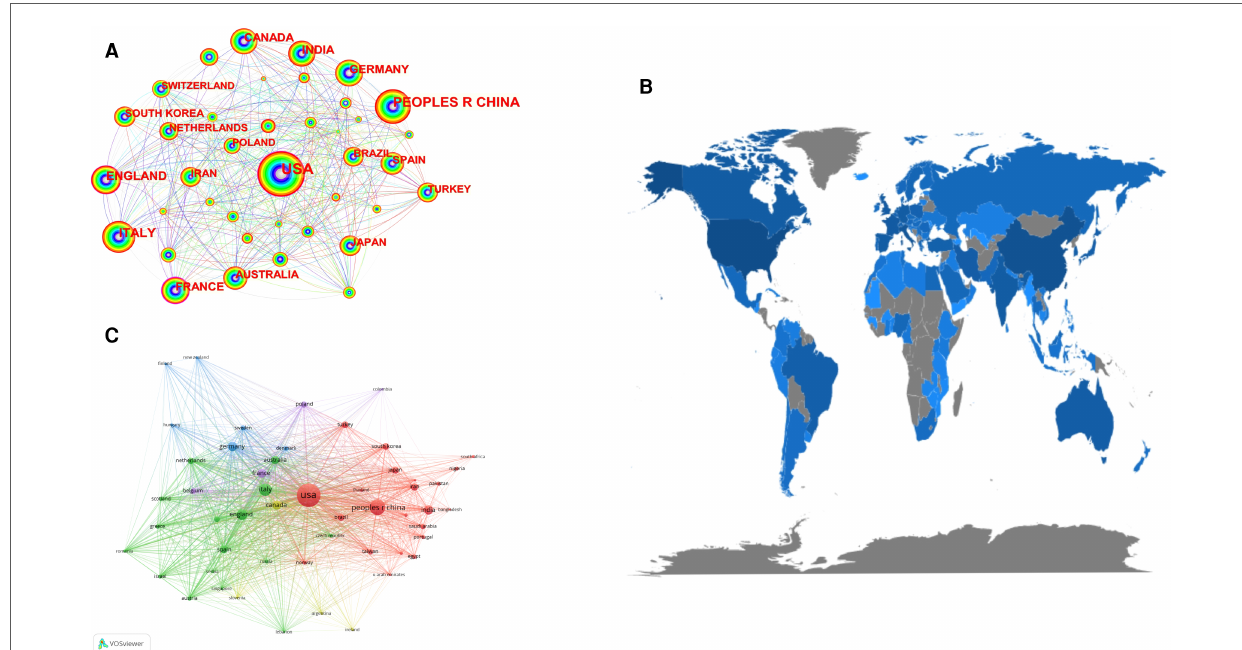
FIGURE 2 ( A ) the co-occurrence map of countries/regions in cardiotoxicity. In the network map, a node represents a country/region and the node size is proportionate to the quantity of publications produced by that country/region. ( B ) World map displaying the global distribution of cardiotoxicity research. Different countries were denoted with different colors based on the number of total citations. ( C ) Citation map of countries/regions on cardiotoxicity research generated by the VOS viewer. Each node represents a different country or region, and the node size is proportionate to the quantity of publications produced by that country. The distance between two nodes indicates the relatedness of their co-authorship link, and a smaller distance implies a stronger correlation of their relatedness. The thickness of the connecting line between nodes indicates link strength of a co-authorship relationship, which could be weighted by a quantitative indicator, that is,